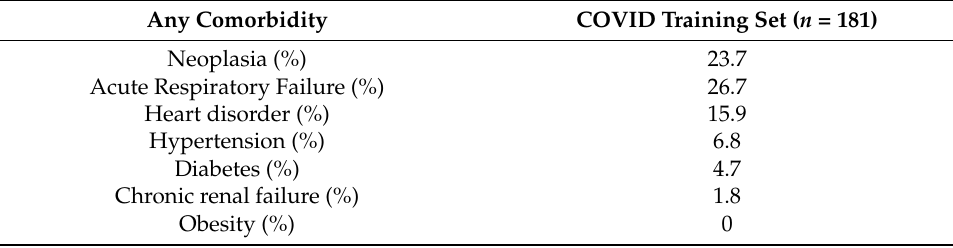
Table 2. Baseline characteristics of the COVID-19 patients used for model